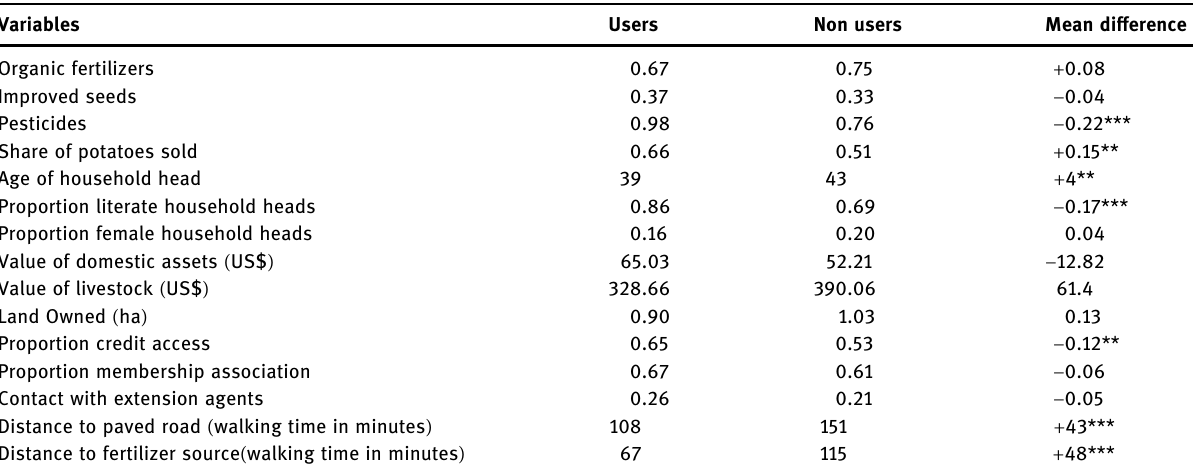
Table 4: Mean di ff erence between farmers using and those not using mineral fertilizers